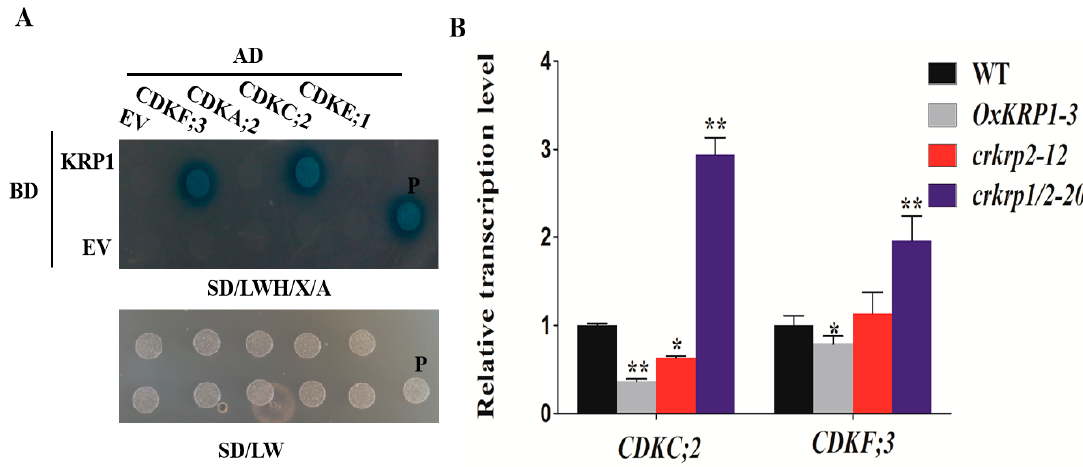
Figure 5. Yeast-two-hybrid assay of KRP1-CDKs interaction. ( A ) Yeast two-hybrid assays. Yeast cells co-transformed with CDKC;2 or CDKF;3 fused to the GAL4 activation domain (CDKC;2-AD or CDKF;3-AD) and KRP1 fused to the GAL4 binding domain (KRP1-BD) were grown on selective media. BD, pGBKT7; AD, pGADT7; EV, empty vector; SD / LW, -Leu-Trp; SD / LWH, -Leu-Trp-His; P, positive control, pGADT7-T + pGBKT7-53; X: X- α -Gal, 0.04 mg / mL; and A: Aureobasidin A, 100 ng / mL. ( B ) qRT-PCR analysis of the transcriptional abundances of CDKC;2 and CDKF;3 in the WT, OxKRP1 , crkrp2 , and crkrp1 / 2 mutants. Error bars indicate the SD with biological triplicates ( n = 3). Asterisks indicate the significant di ff erence between the WT and transgenic lines, as determined by Student’s t -test analysis: * p < 0.05, ** p < 0.01. WT: wild type. The primers used for qRT-PCR analysis were listed in Table S1.